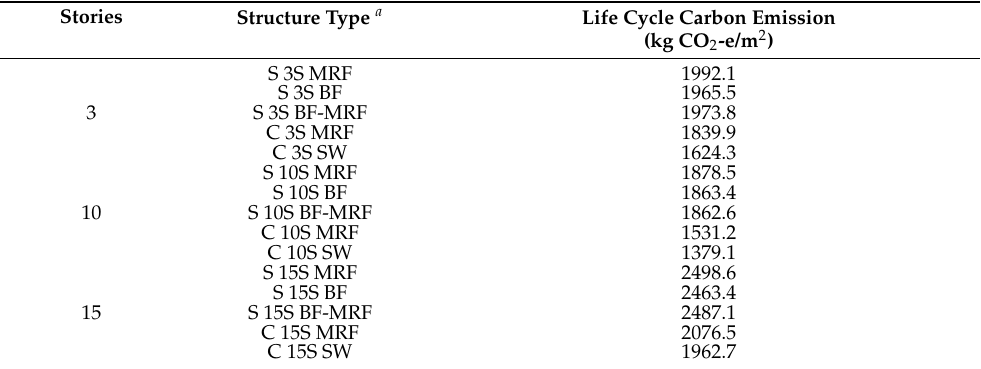
Table 9. The cumulative life cycle CO 2 emissions correlated with various systemic structures per square meter (Reproduced from [39], the name of the publisher: Elsevier).